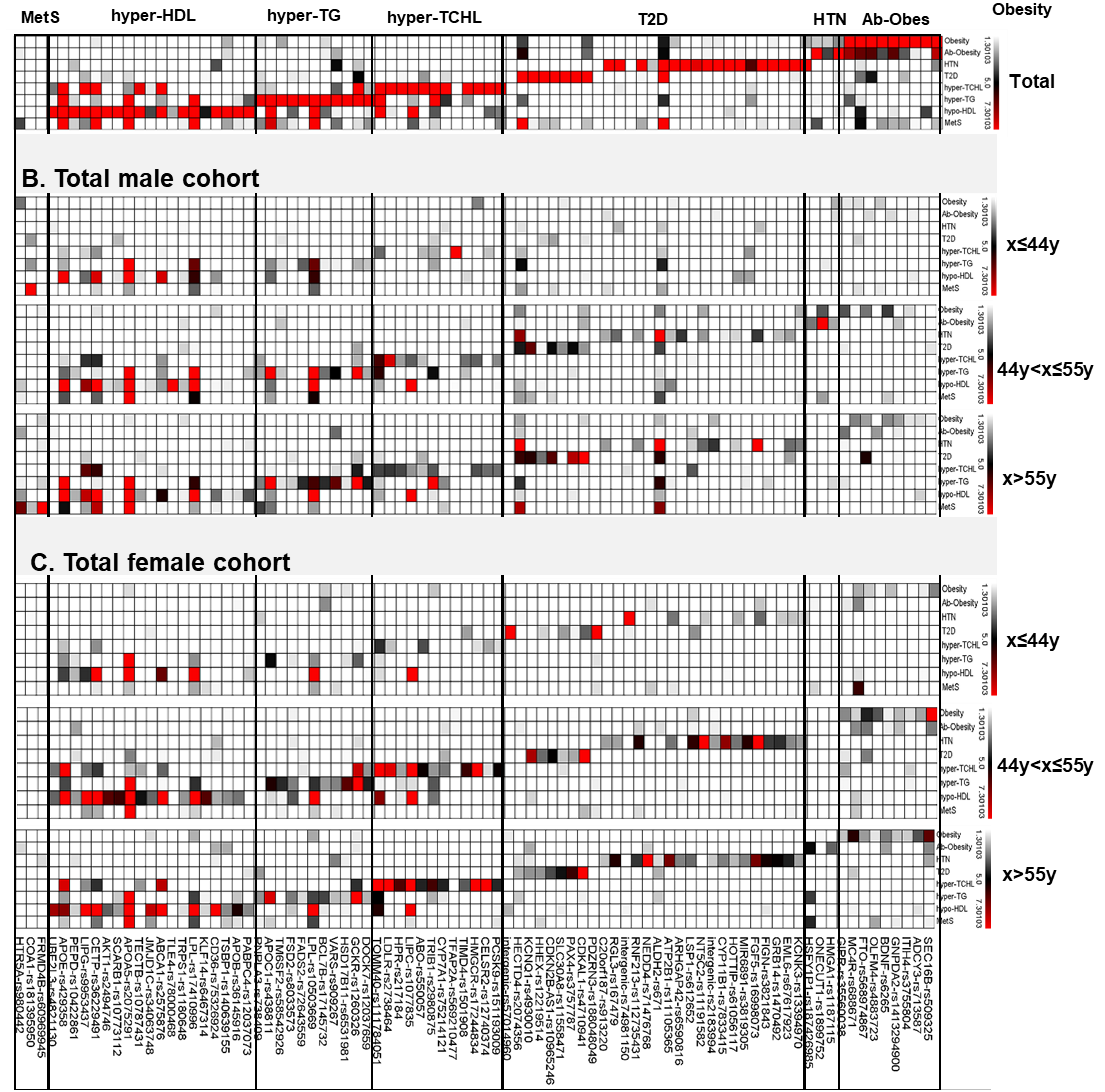
Figure 3. Heat-map analysis based on genome-wide association study results. A red mark means an association with a p -value of less than 5 × 10 − 8 , and black or gray means a case that shows a p -value between 0.05 and 5 × 10 − 8 , although not 5 × 10 − 8 significance. ( A ) shows the significant results confirmed in the GWAS analysis using the entire sample, ( B ) shows the results for the male group, and ( C ) shows the results for the female